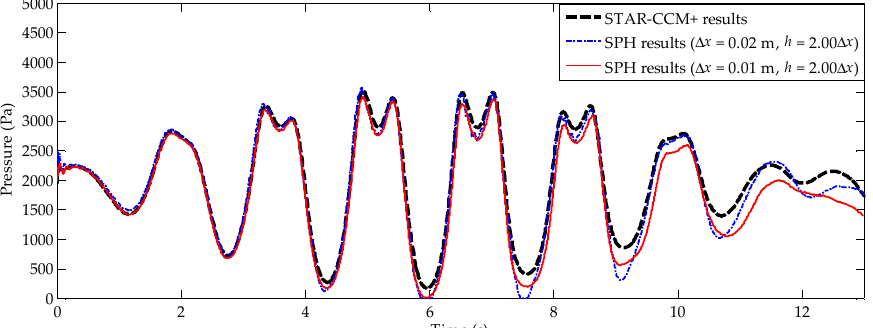
Figure 31. Comparison of the SPH results obtained with h = 2.00 ∆ x for the pressure on the solid boundary with those of STAR-CCM+.